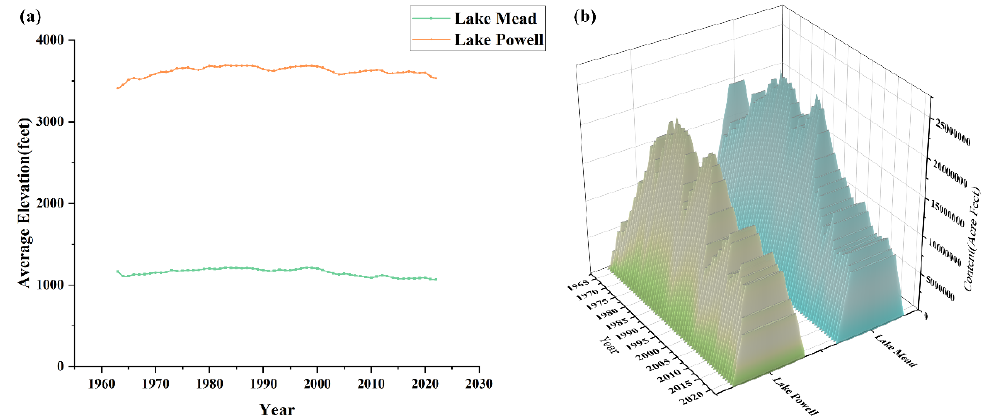
Figure 8. The water level of Lake Mead and Lake Powell from 1963 to 2022. ( a ) The average eleva- tion. ( b ) The content. Source: National Water Information System https://waterdata.usgs.gov/nwis (accessed on 20 January 2022).